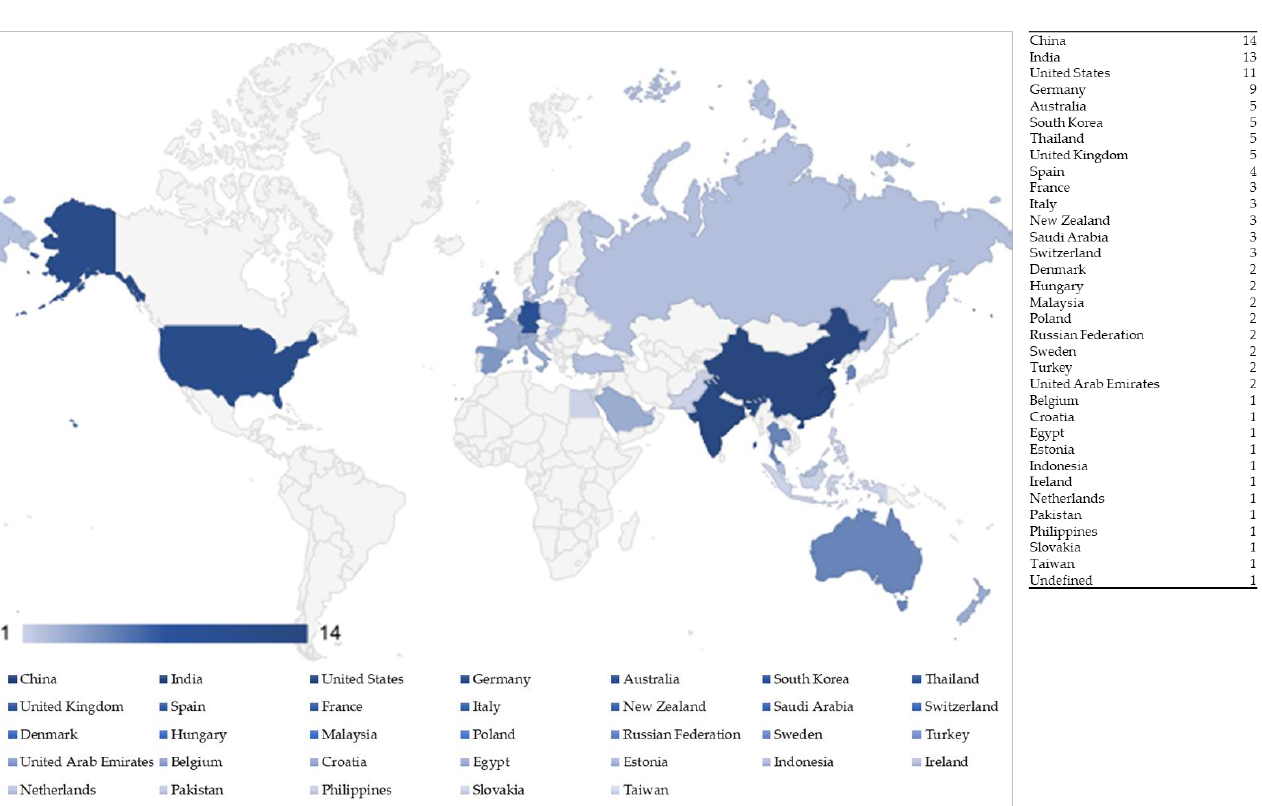
Figure 4. The primary keywords used in the articles.